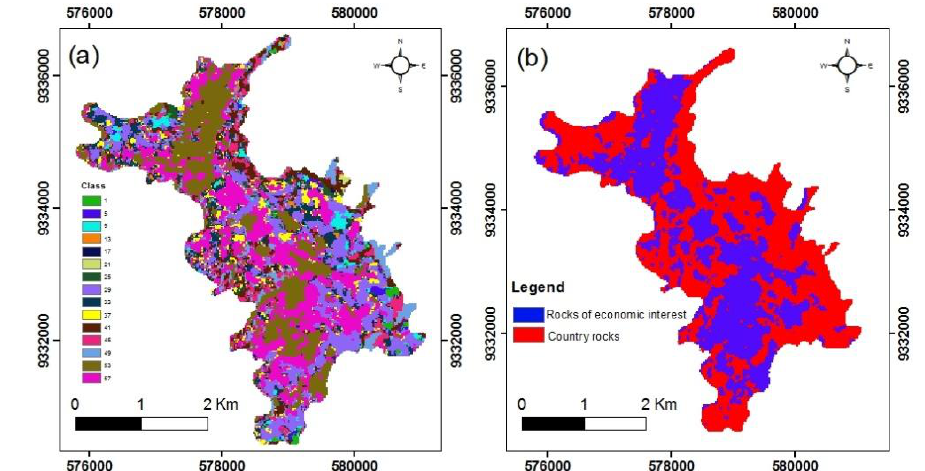
Figure 11. Classification of the R99B images using hybrid methods: ( a ) image classified by the Wishart-Freman-Durden method; ( b ) composite image classified by the Wishart-Freman-Durden